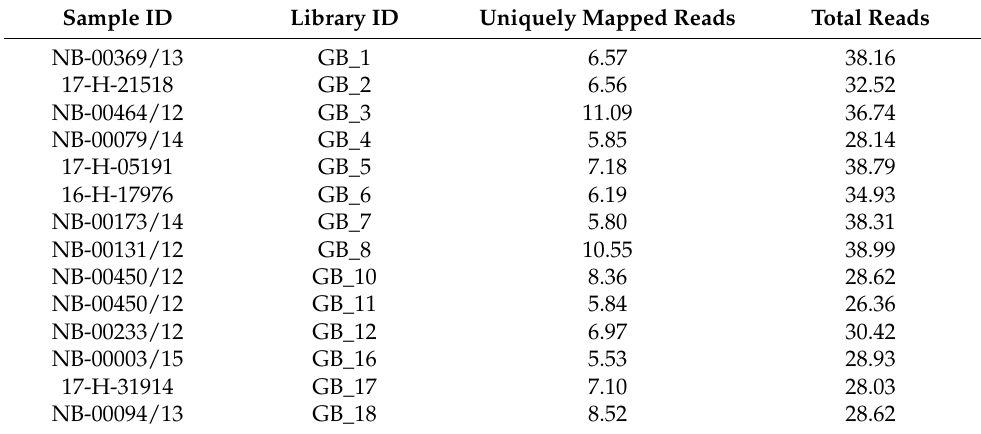
Table 2. RNA sequencing statistics.